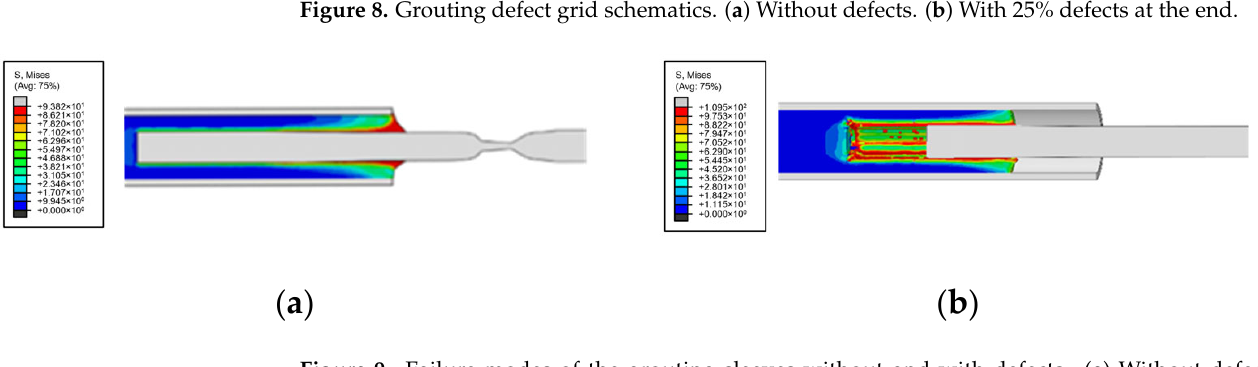
( b ) With 25% defects at the